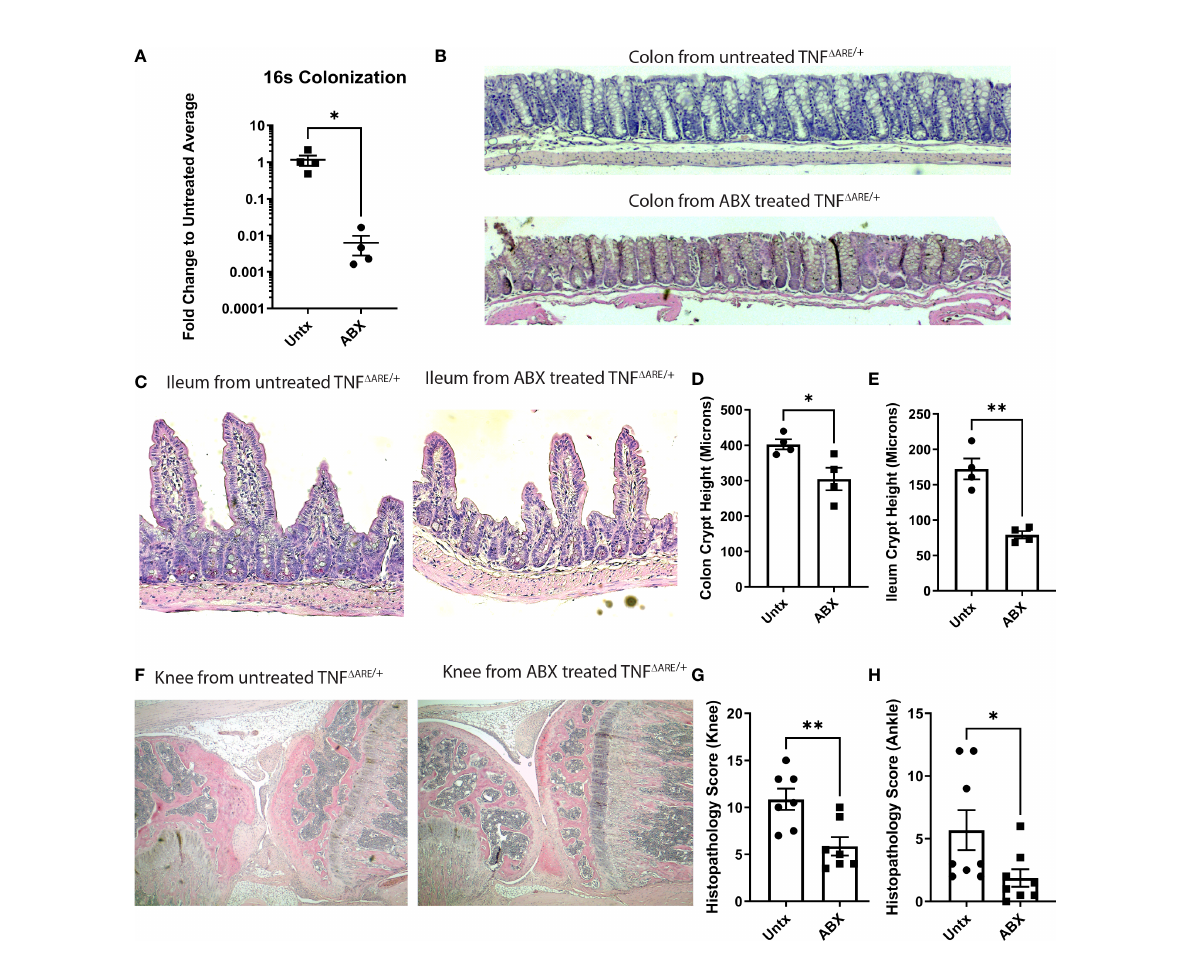
FIGURE 5 Antibiotics ameliorate disease in TNF D ARE/+ mice. Male and female KikGR+ TNF D ARE/+ mice were given either broad spectrum antibiotics, consisting of ampicillin, neomycin, metronidazole, and vancomycin in 10% grape Kool-Aid (n=7) or Kool-Aid alone as vehicle (n=7) ad libitum in the drinking water from 4-16 weeks of age. (A) Depletion of bacteria was assessed by 16S rRNA gene qPCR. At 16 weeks mice were euthanized and the colon, terminal ileum, knees, and ankles were harvested and processed for histology. (B, C) Representative histology of the (B) colon and (C) ileum from a control and antibiotic (ABX) treated TNF D ARE/+ mouse is shown at 100X. Histology of the (D) colon and (E) ileum was evaluated for crypt height assessed in 5 fi elds viewed at 100X magni fi cation. The mean length in microns for each individual mouse is represented as a symbol while the bars are the mean ± SEM for the group. (F) Representative histology of the knee from a control (left) and ABX treated (right) mouse is shown at 40X magni fi cation. Histopathology of the (G) ankles and (H) knees were scored by a blinded reviewer from 0- 4 (0=none; 1=minimal; 2= mild; 3=moderate; 4=severe) on each of the following metrics, and results summed to generate a histopathology score: in fl ammatory in fi ltrate, synovio-enthesitis, cartilage loss, and bone destruction. Data are shown as individual mice (symbols) with bars as mean ± SEM. *P<0.05; **P<0.01 as determined by Student ’ s T